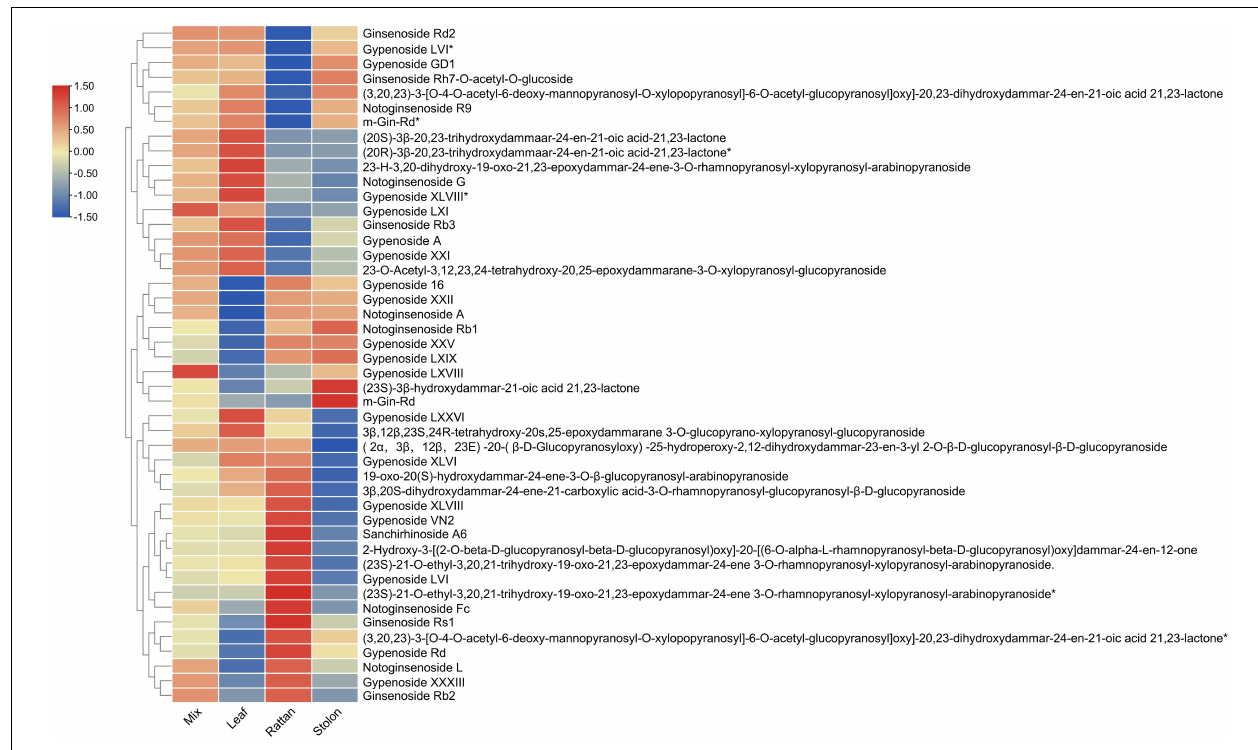
FIGURE 2 | The heatmap of triterpene content level in leaf, rattan, stolon and whole plant of G. longipes